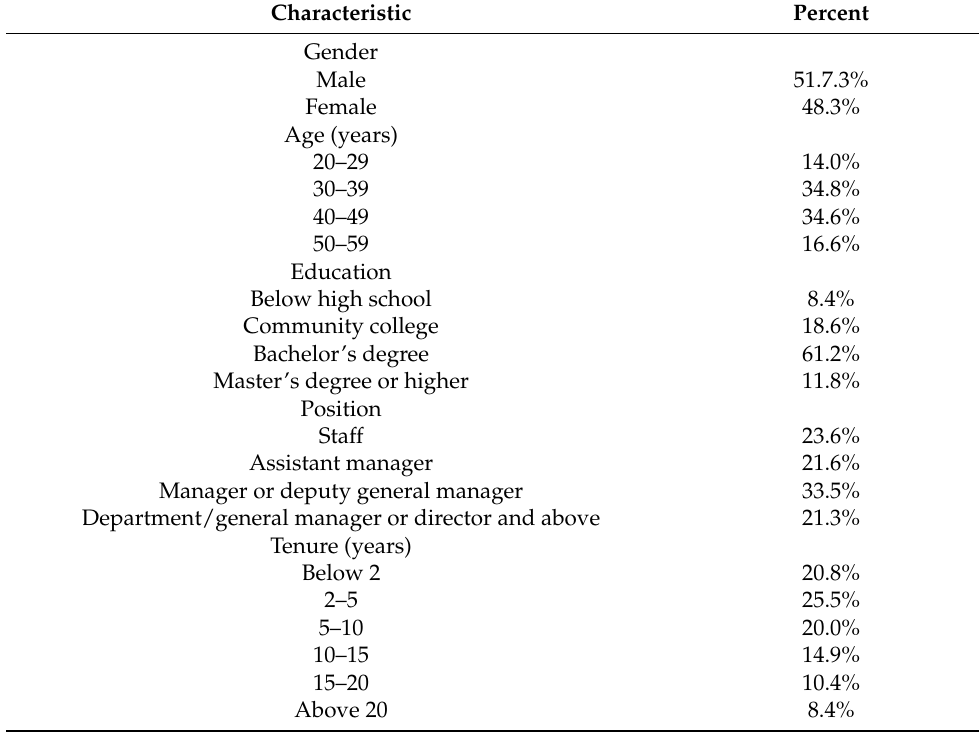
Table 1. Descriptive Features of the